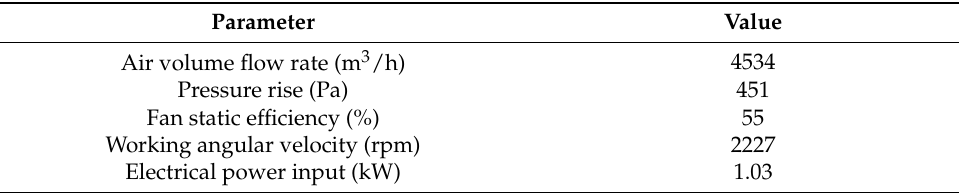
Table 3. Real operating conditions of the supply